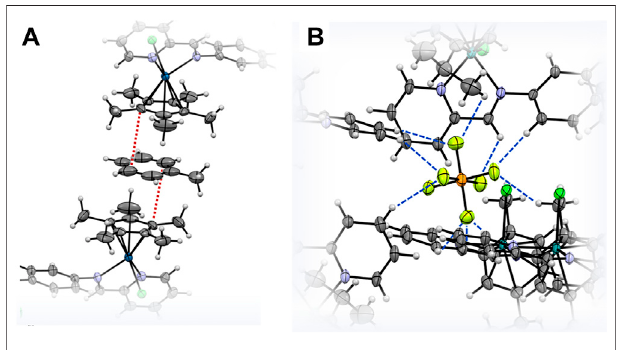
FIGURE 5 | ORTEP representation of (A) co-crystallized toluene π -bonding with the Cp* ligands of two adjacent molecules of 2d , and (B) H-bonding network around a PF 6 − counteranion and 2a molecules. The shortest C – C distances at 3.604 Å in (A) are highlighted by red dashed lines while the H bonds in (B) are indicated in blue.